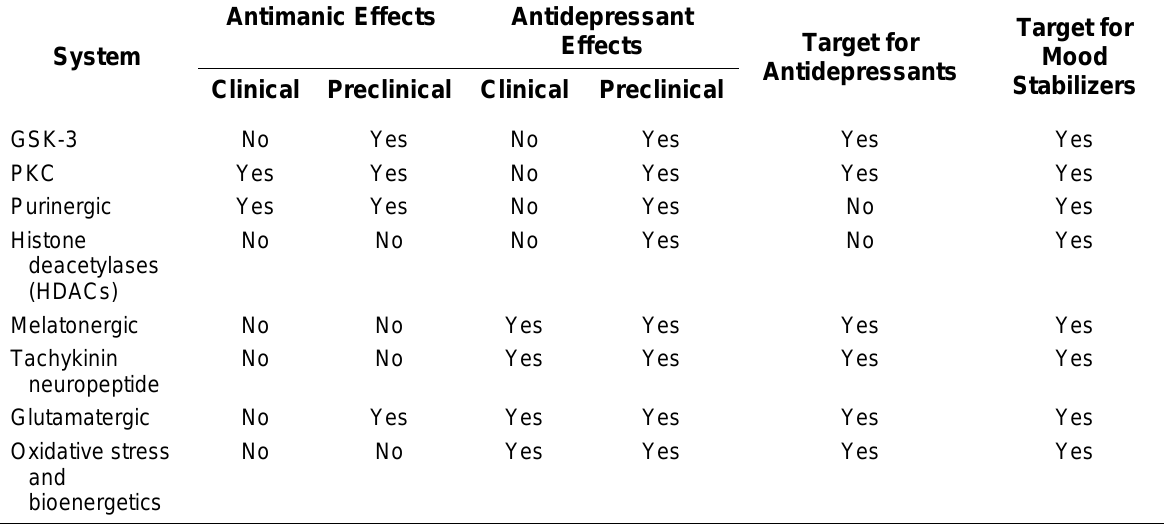
New Therapeutic Targets in Mood Disorders: Current Evidence for Antimanic (-Like)/ Antidepressant (-Like) Effects and Effects of Standard Antidepressants/Mood Stabilizers at these